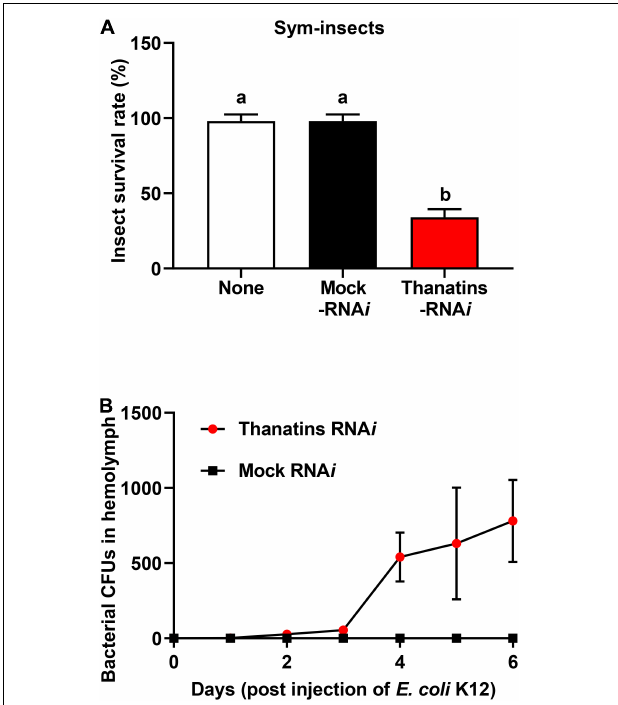
FIGURE 6 | Insecticidal effect of Burkholderia gut symbionts in the hemolymph during systemic E. coli K12 injection. (A) Survival rates of the thanatin gene-silenced Sym-male insects upon systemic E. coli K12 injection. Data are expressed as mean ± SD ( n = 10). Different letters (a and b) on the top of the columns indicate statistically significant differences ( P < 0.05; one-way ANOVA with Tukey’s correction). (B) Comparison of the symbiont cells detected in insect’s hemolymph by RNA i and systemic E. coli K12 injection. Data are expressed as mean ± SD ( n = 3). All data are representative of three independent experiments.